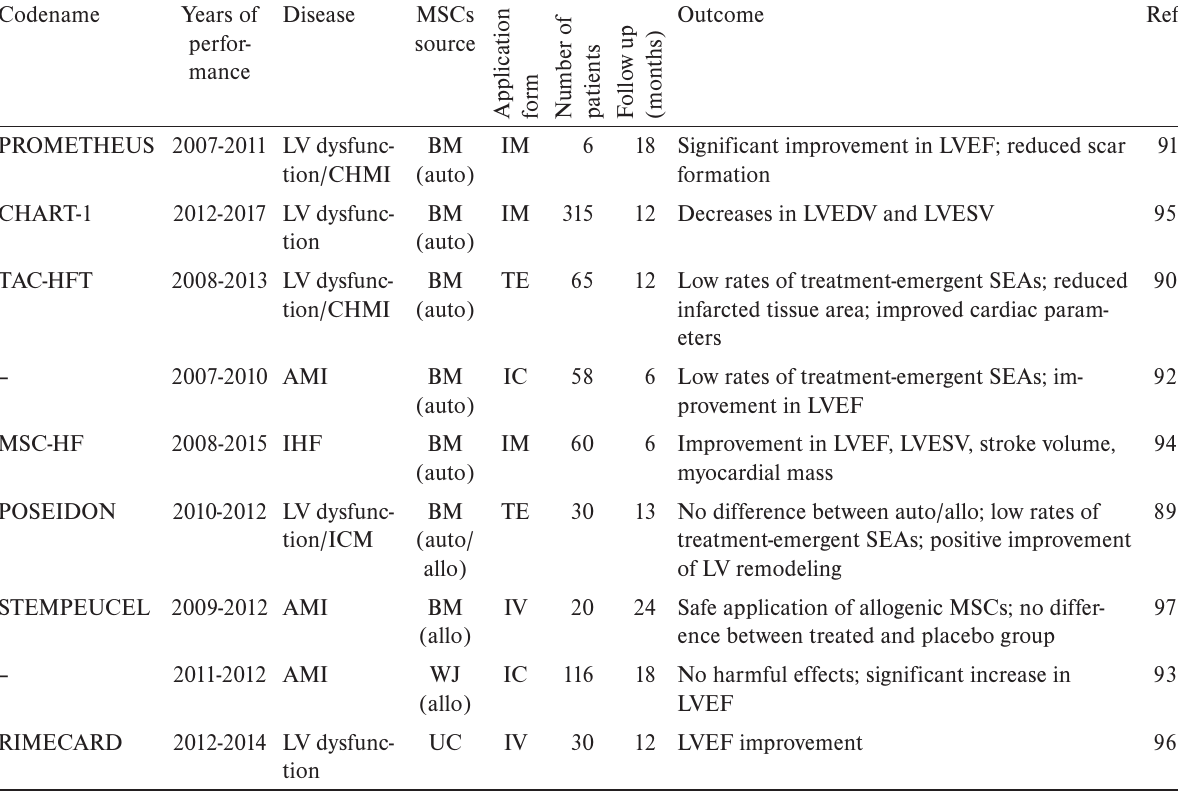
Table 2. Clinical trials of MSCs application for cardiac function